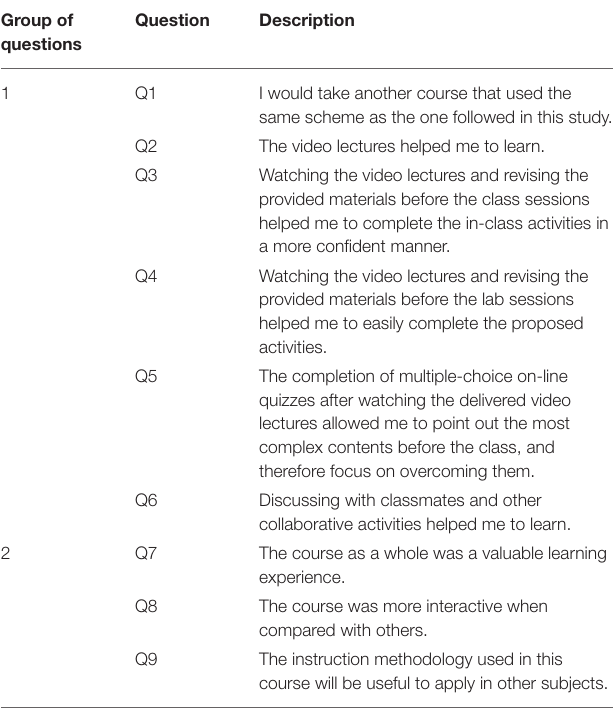
TABLE 3 | Five-points Likert-type survey used in this study to compare the F2F and F2S in terms of PST’s perception change (Section Results and discussion). Group of questions